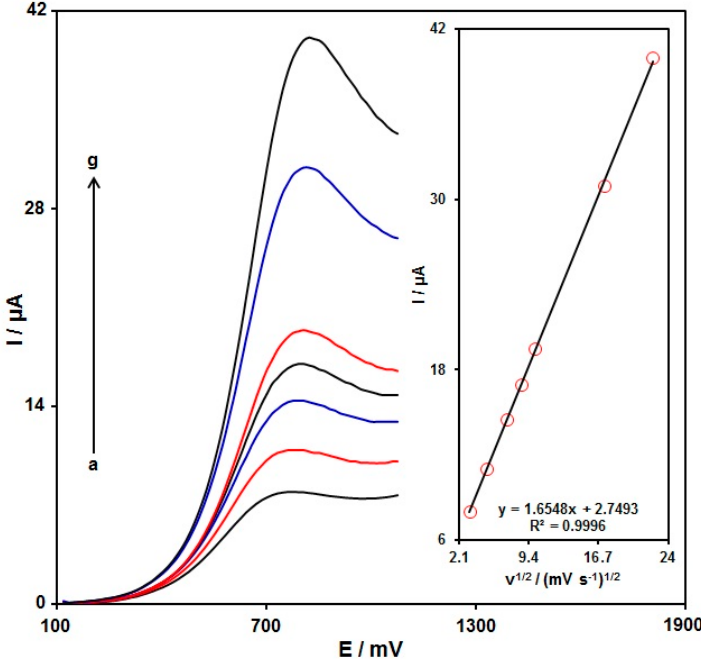
Figure 6. LSV recorded for the PPy NTs/GSPE in 0.1 M PBS at pH = 7 with 100.0 µ M hydroxylamine at variable scan rates. Nos. a–g: 10, 25, 50, 75, 100, 300, and 500 mV/s, sequentially. Inset: variation of the anodic peak current versus ν 1/2 .